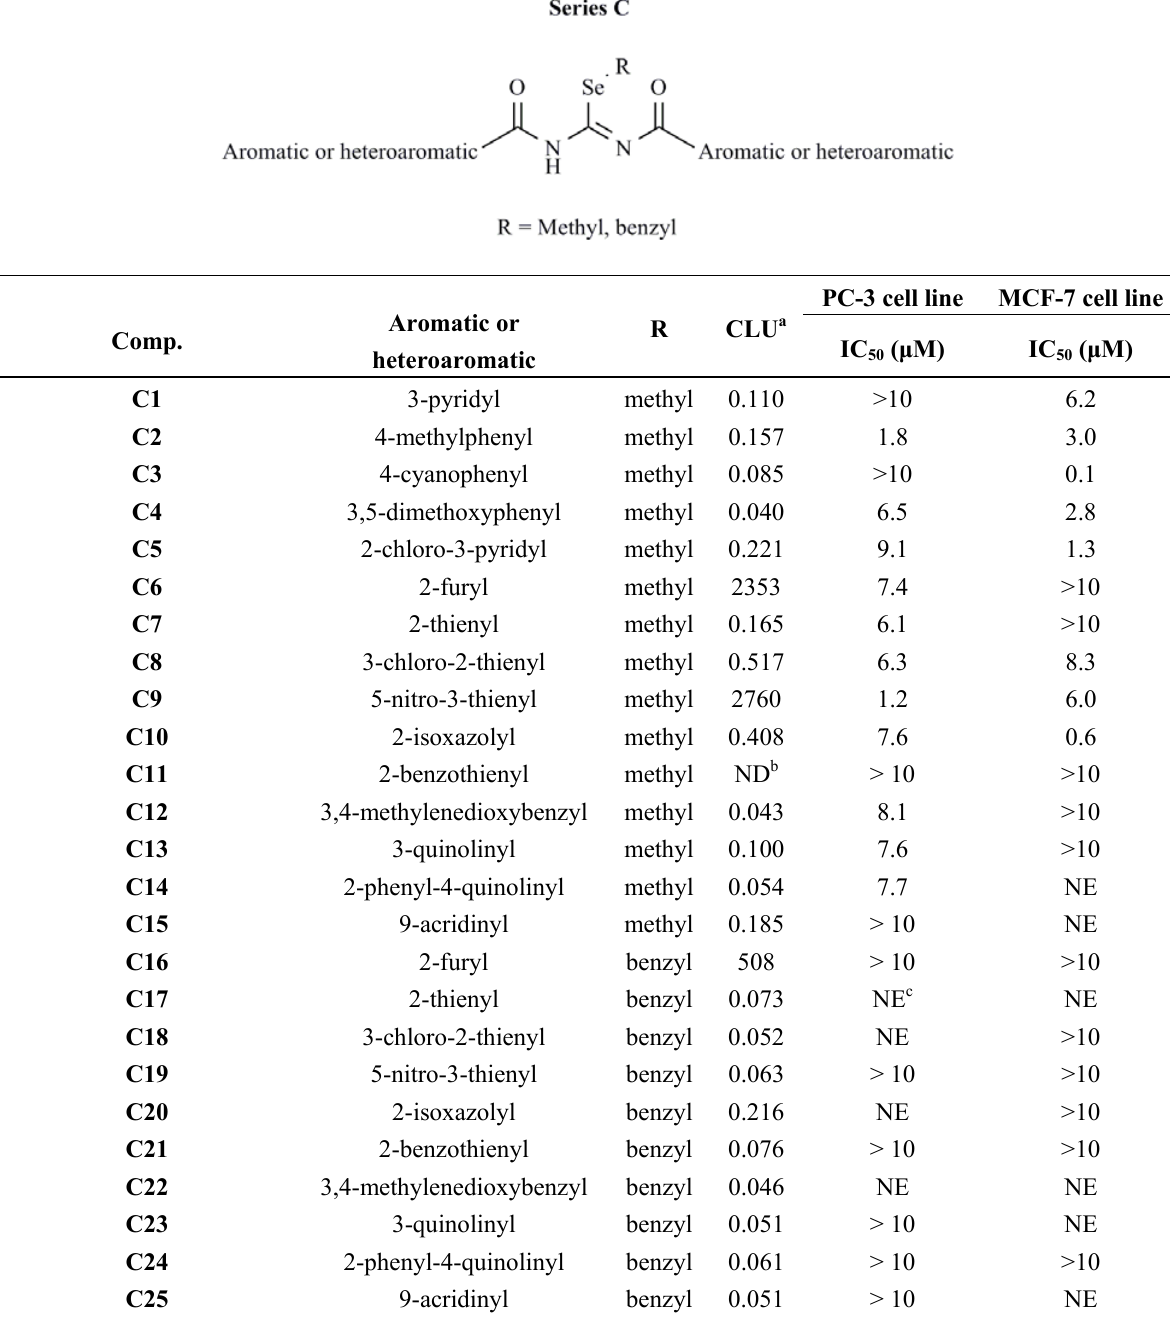
) of the compounds C1 - C25 . 50